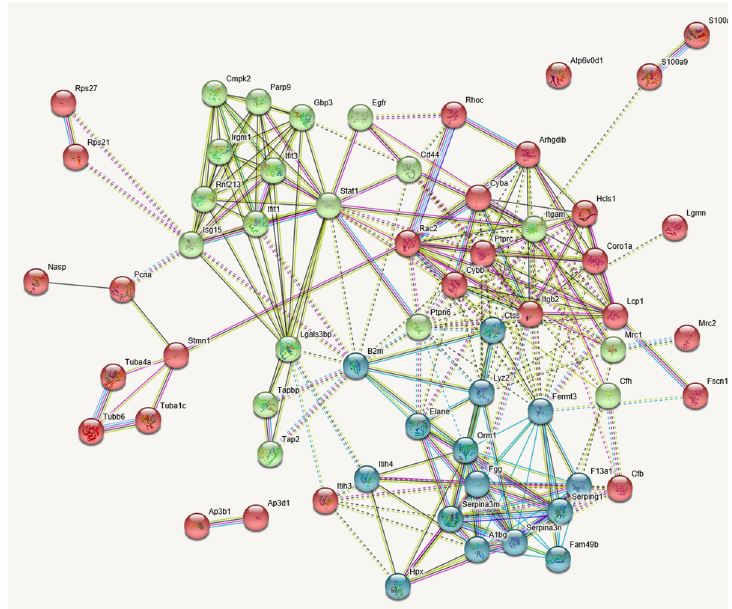
Fig 6. String analysis showed three dominating clusters when comparing metastasis (day 54) to the pre-metastatic group (day 19) in lung tissue. The blue cluster predominantly represented proteins involved with processes in inflammation, immune response, cell-cell interaction, haemostasis and haematopoiesis. The green cluster involved immune response, DNA damage, EGF receptor and haematopoiesis, and the red cluster involved metabolism, organisation of the cytoskeleton, cell movement and immune response.